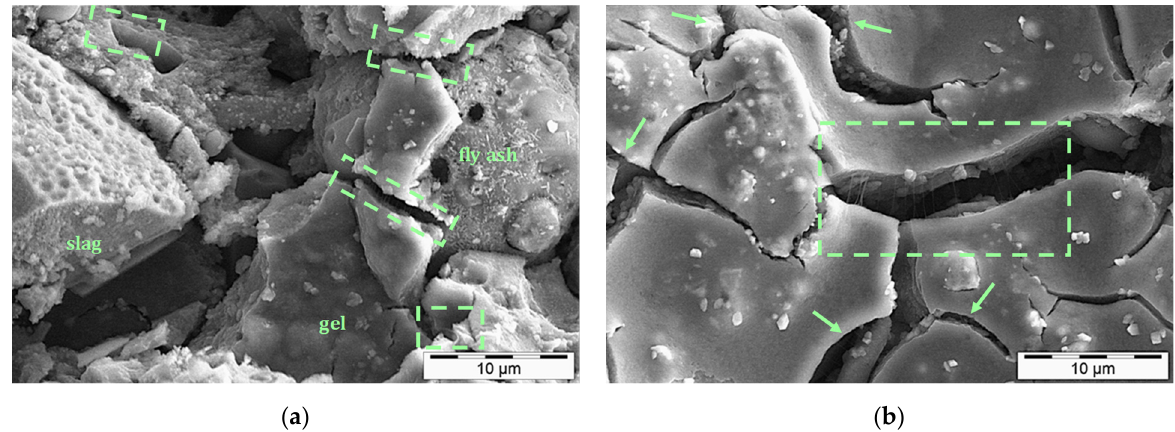
Figure 8. SWCNTs’ distribution in 28-day one-part SWCNT-alkali-activated nanocomposites, SWCNT conc. 1.0 wt.%. SWCNTs are highlighted with green arrows and boxes. ( a ) and ( b ) show different regions in the microstructure. The multifunctional capabilities of SWCNTs are demonstrated in Figure 9. Microcrack